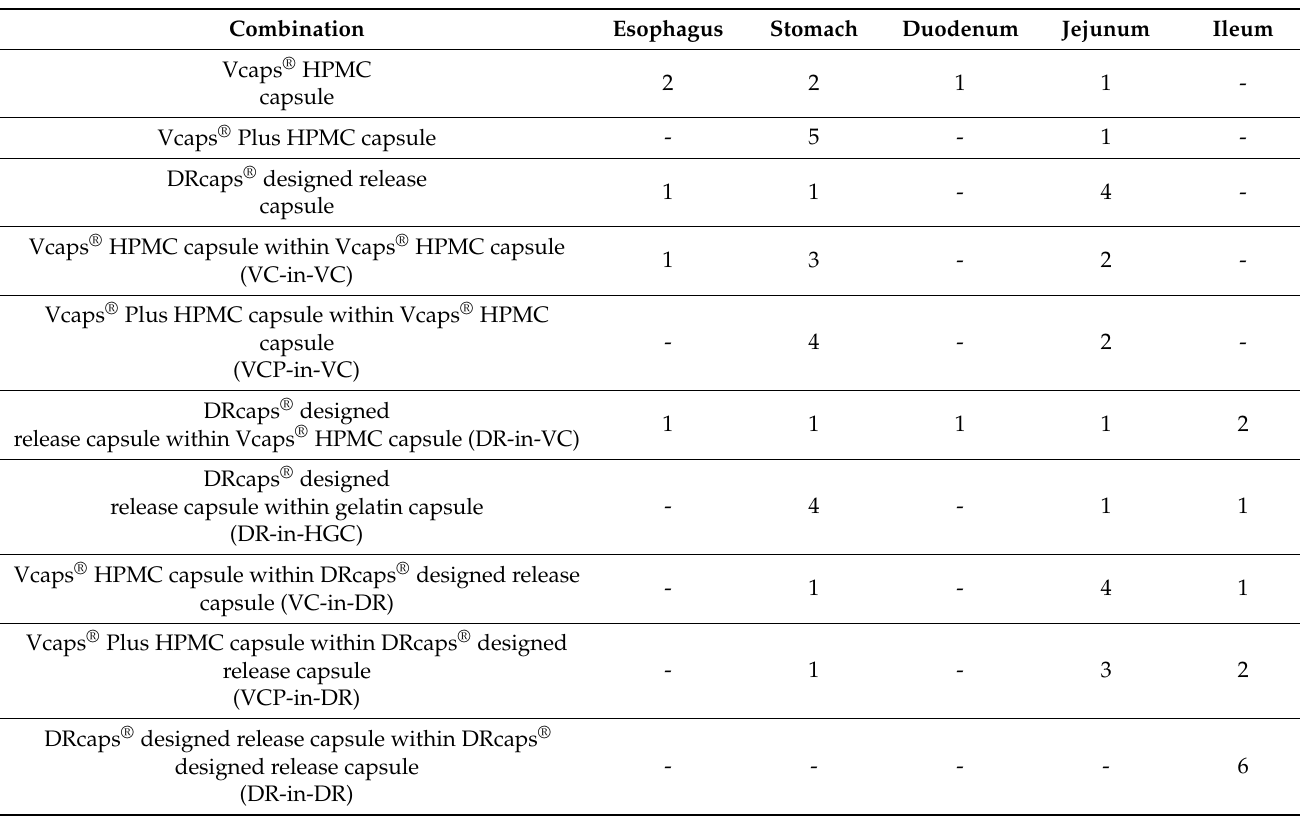
Table 3. Study arms and respective disintegration